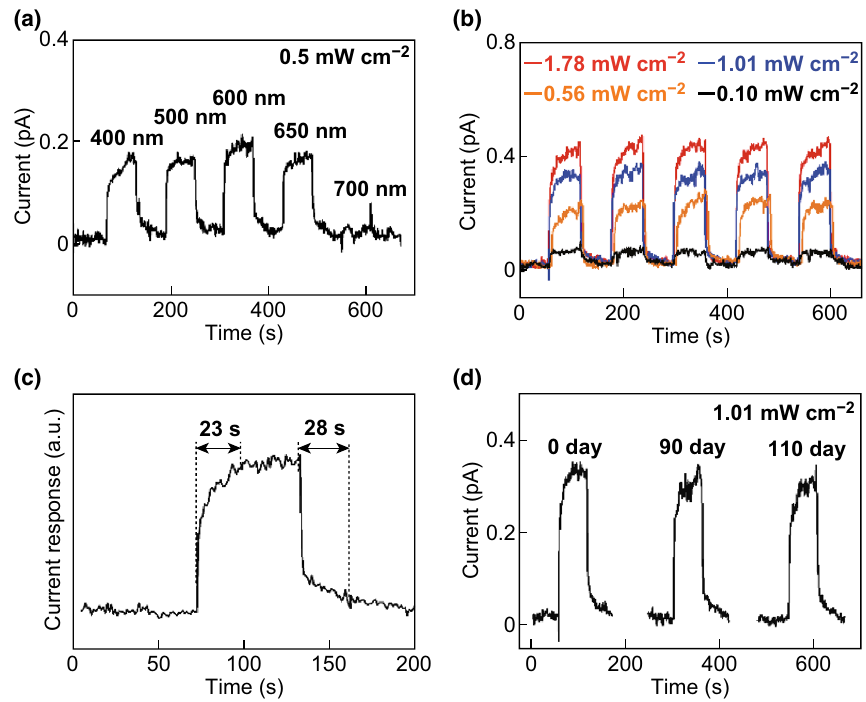
Fig. 7 a Photodetector responses to light with various wavelengths and energy density of 0.5 mW cm −2 . b Photodetector responses to 600 nm light of different intensities. c Response and recovery times of the photodetectors. The intensity of the incident light (600 nm) is 0.56 mW cm −2 . d Long-term performance of the Mo 2 C/MoS 2 /Au photodetector under illumination with 600 nm